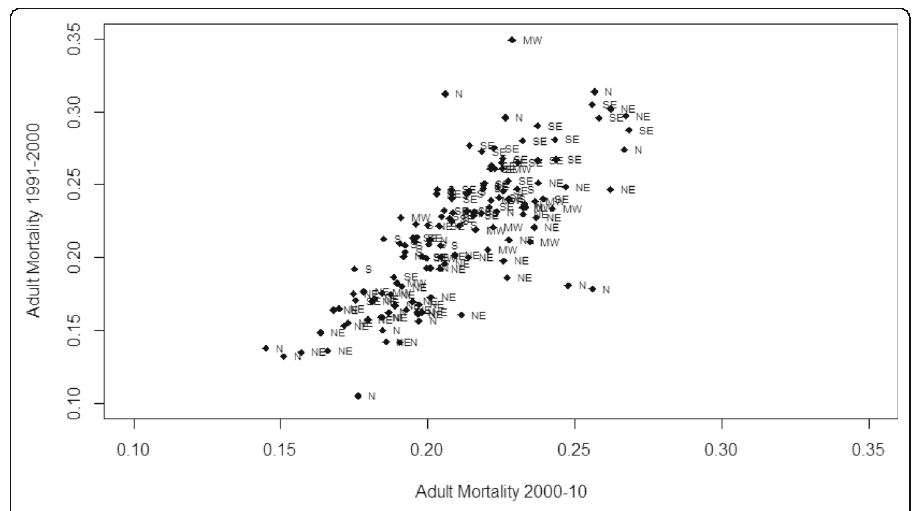
Fig. 5 Relationship between adult mortality probabilities in two periods, Males, Brazil (1980/1991 and 2000/ 2010). Source: IBGE (1980, 1991 and 2000) and DATASUS